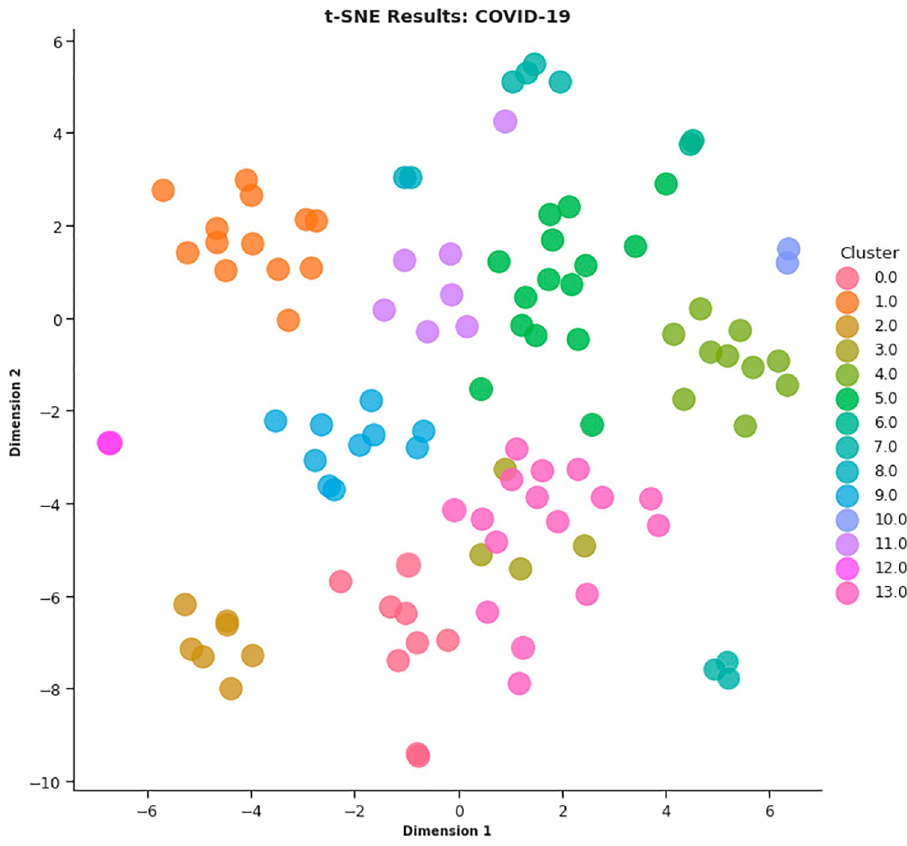
Fig 24. t-SNE visualization of clusters for